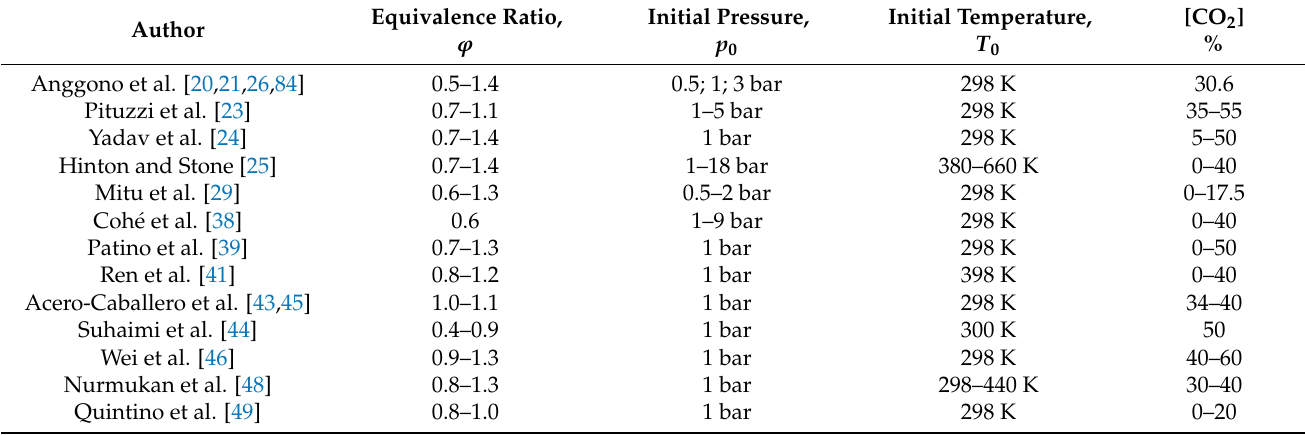
Table 3. Initial conditions for obtaining the laminar burning velocities of biogas-air and synthetic biogas (CH 4 /CO 2 )-air flames described in the present